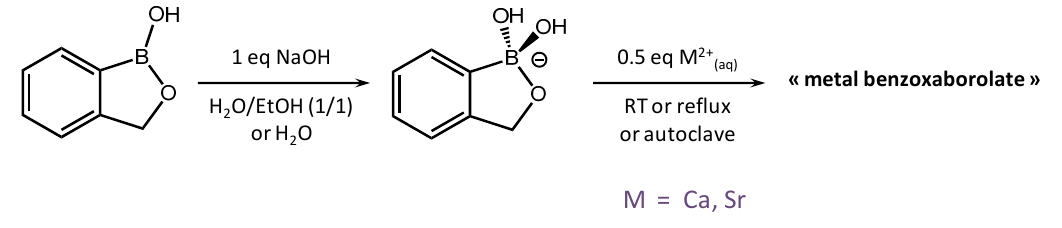
Figure 6. Reaction scheme for the formation of metal benzoxaborolate crystalline structures by precipitation.